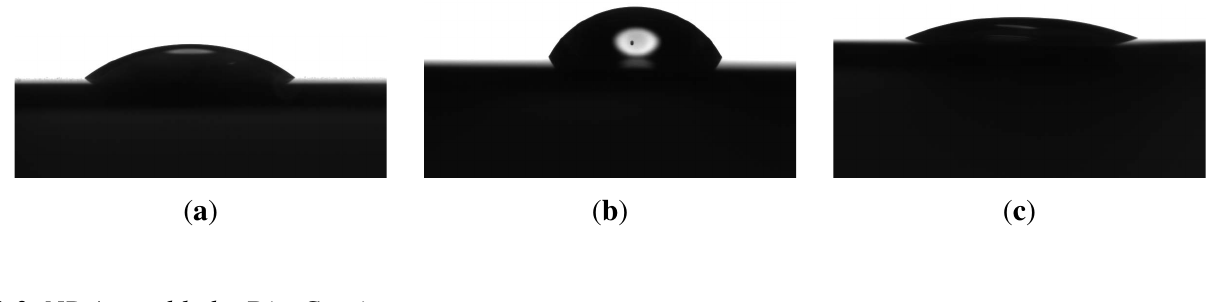
Figure 3. Water CA values of Si/PEI/(PSS/PAH) 2 , 33 ◦ ( a ); PDMAEMA brushes, 59 ◦ ( b ) and QPDMAEMA brushes, 21 ◦ ( c